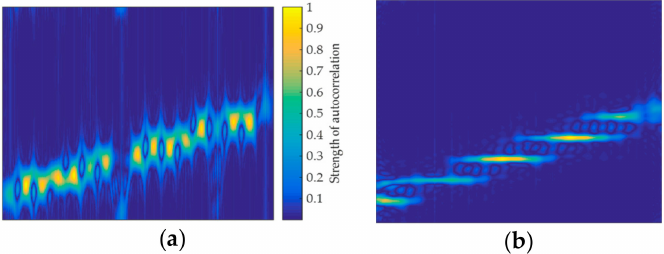
Figure 11. Window function selection analysis of short-time auto-correlation images when SNR is 0 dB: ( a ) Kaiser window for LFM. ( b ) Hamming window for